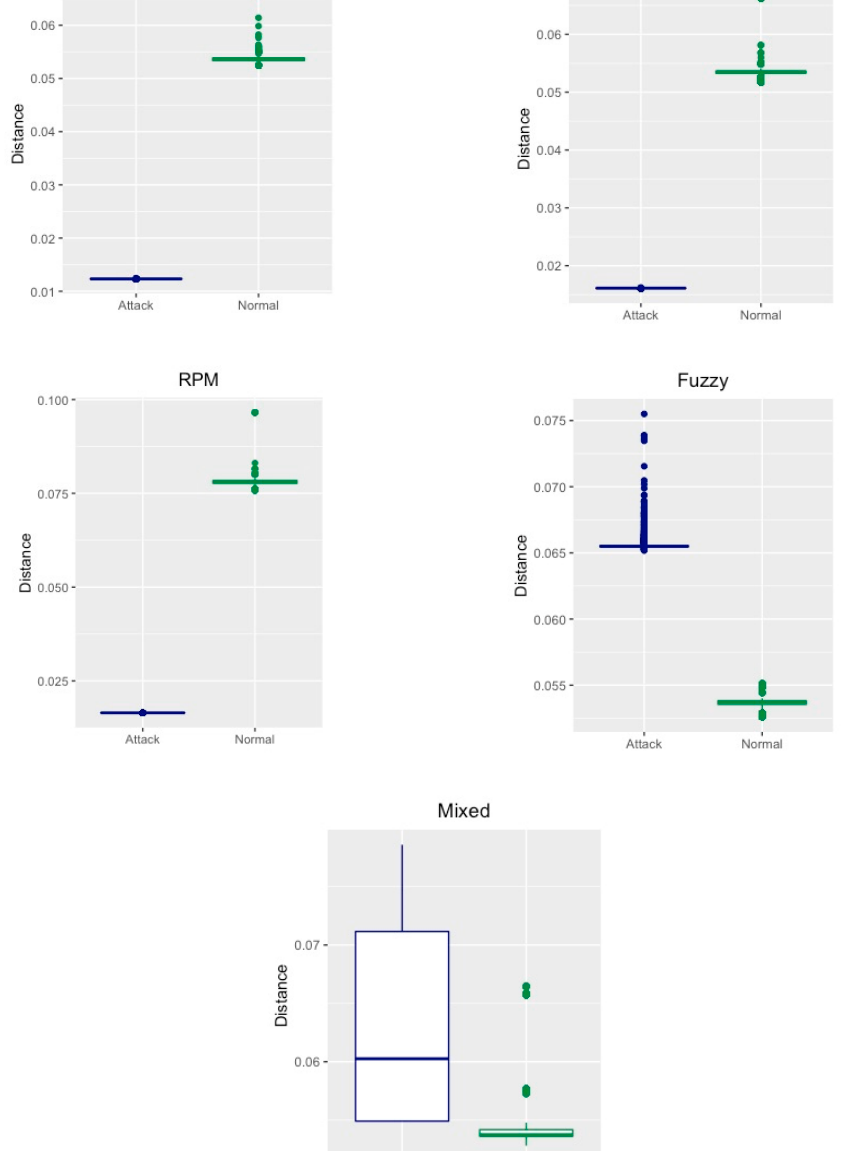
Figure 8. Distances between the input vectors and the winning neurons for XYF network on the 2 × 2 neurons map.